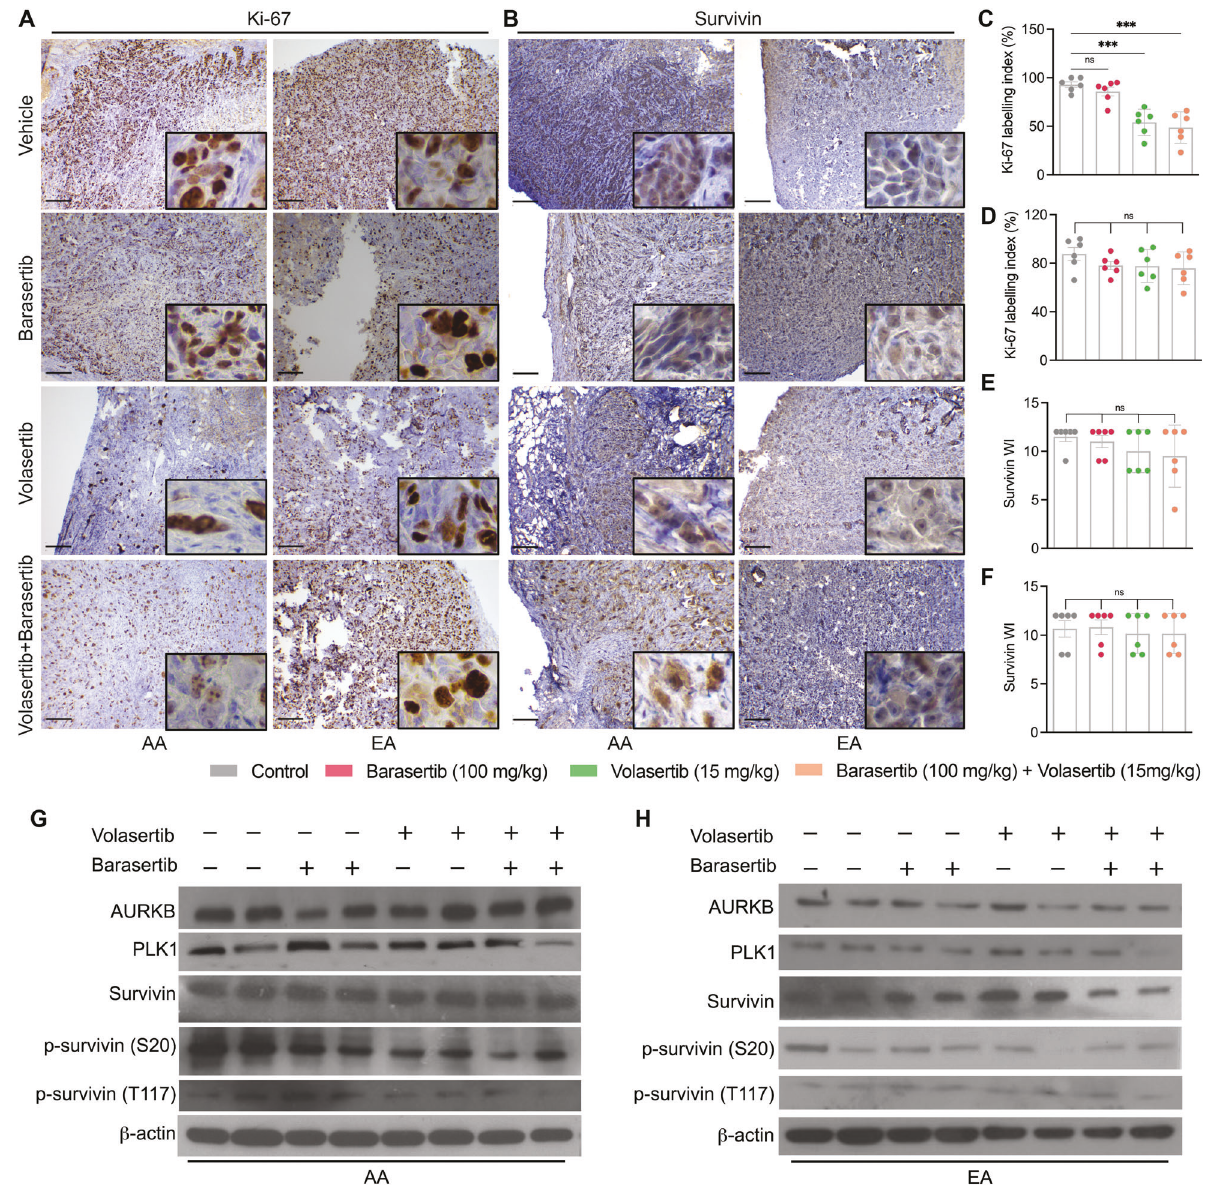
Fig. 6 Inhibition of PLK1 and AURKB decreases Ki-67 and p-survivin levels in mice bearing AA TNBC tumors. A – F Representative IHC images ( A , B ) and bar graphs ( C – F ) showing Ki-67 and survivin levels in AA ( C , E ) and EA ( D , F ) TNBC xenografts under various treatment conditions. G , H Immunoblots showing the levels of p-survivin (T117), p-survivin (S20), total survivin, AURKB, PLK1, and β -actin in AA ( G ) and EA ( H ) fresh-frozen xenograft tumor lysates from mice treated with volasertib, barasertib, or their combination ( n = 12 per treatment group). Bars represent mean ± SEM. Unpaired two-tailed Student ’ s t -test with Welch ’ s correction was used to determine statistical signi fi cance (**** P < 0.00005, ns = non-signi fi cant). The scale bar represents 100 µm. tumor size, lymph node metastasis, and poor survival in patients attractive anticancer approach [34, 35]. However, to the best of with TNBC. However, the differential function of survivin in racially our knowledge, no studies have shown the role of PTMs in racial diverse TNBC populations has remained unappreciated. disparities in TNBC. Despite the similar expression levels and localization patterns of Our in silico analyses revealed signi fi cantly higher expression survivin in AA and EA patients with TNBC, survivin silencing or levels of PLK1 and AURKB in AA patients with TNBC than in their inhibition inhibited cell proliferation and cell cycle progression EA counterparts. Survivin, an IAP family member and substrate of exclusively in AA TNBC cells. Our data suggest that survivin PLK1 and AURKB, is involved in carcinogenesis, tumor progression, phosphorylation at S20 and T117 by PLK1 and AURKB is essential cancer cell proliferation, inhibition of apoptosis, neoangiogenesis, for tumor progression in AA patients with TNBC and contributes to and drug resistance [36, 37]. Because of the higher expression of racial disparities in TNBC. This is the fi rst study to propose that in survivin in cancer cells than in normal tissues, modulating the AAs, TNBCs rely on survivin phosphorylation by PLK1 and AURKB expression and function of survivin in cancer cells may have little for cell proliferation and cell cycle progression. PLK1 and AURKB to no toxic effects on the surrounding normal tissues. Zhang et al. inhibition using small molecule inhibitors inhibited survivin [16] reported a signi fi cant correlation between survivin levels and Cell Death and Disease (2023)